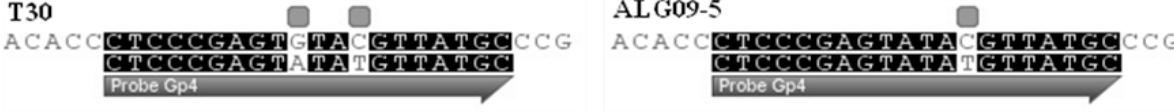
Figure 3. Annealing region of probe from group 4 in the sequences of isolates T30 (reference isolate from group M) and